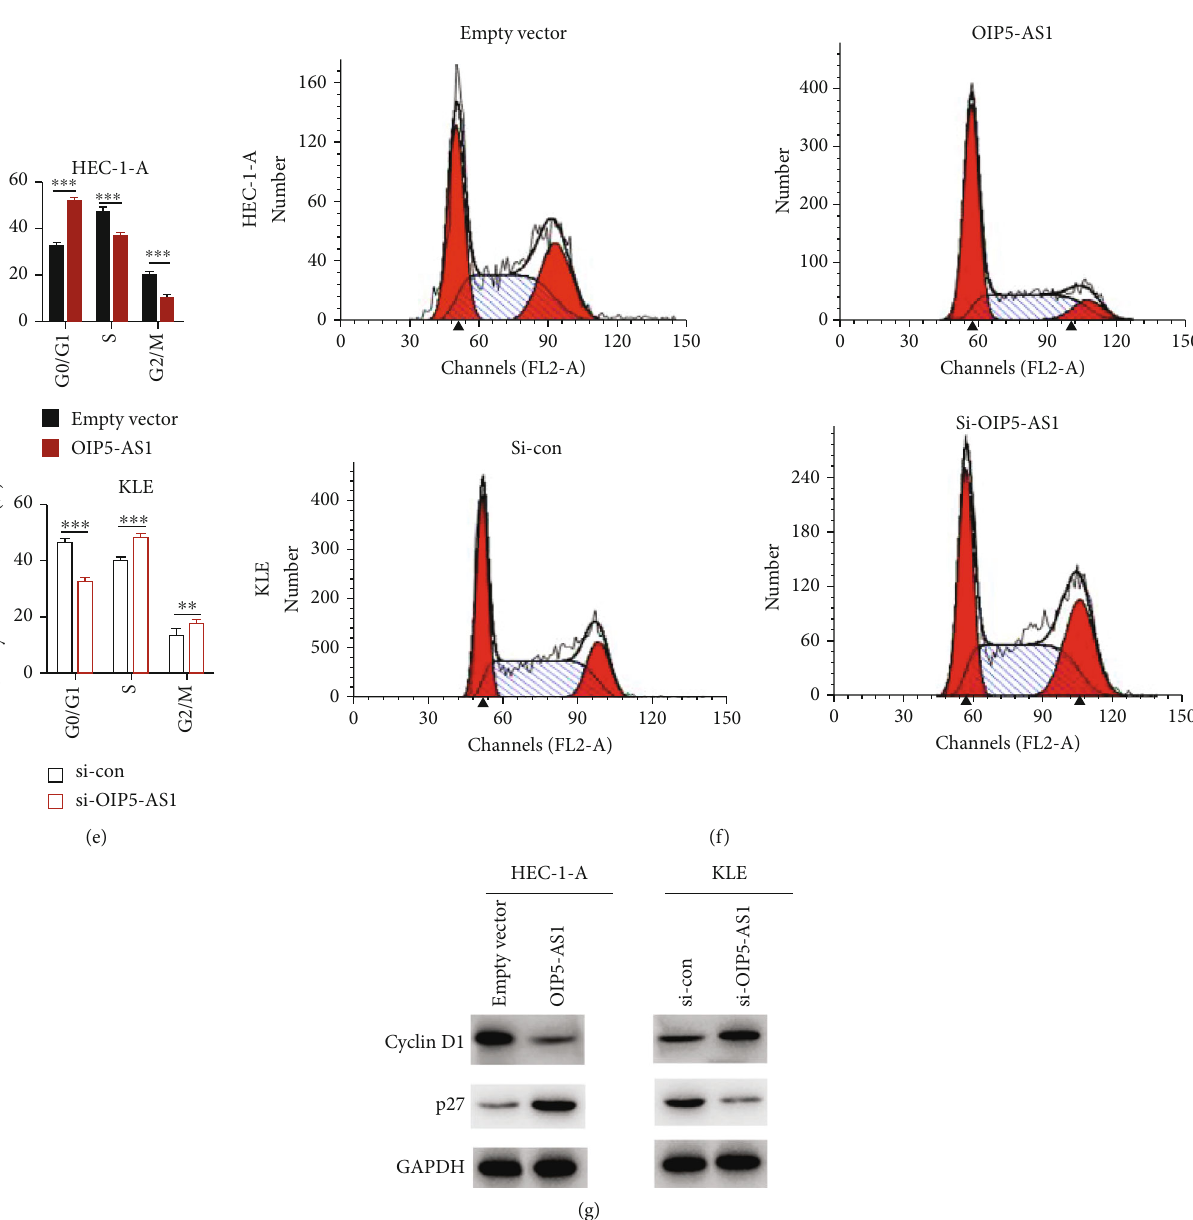
Figure 2: Upregulation of lncRNA OIP5-AS1 inhibited the proliferation of EC cell in vitro. (a) qRT-PCR was conducted to evaluate the expression of OIP5-AS1 in EC cell lines. After being transfected, OIP5-AS1 was signi fi cantly upregulated in the HEC-1A cell line compared with the empty vector group. Meanwhile, OIP5-AS1 was reduced in the KLE cell line by transfecting with the anti-OIP5-AS1 sequence. ∗∗∗ P < 0 : 001 . (b) CCK8 assay was used to measure cell vitality of HEC-1-A and KLE cells after transfection for 12, 24, 48, and 72 hours. (c) EDU staining was applied to label the DNA synthesis in HEC-1-A and KLE cells, which were transfected with OIP5-AS1 and its interfering RNA. Green represents EDU-positive cells; blue represents the cell nucleus. Scale bar 100 μ M. (d) Statistical result of EDU-positive cells. (e, f) Cell cycle was determined by fl ow cytometry. (g) Western blot analysis of cell cycle-related protein Cyclin D and p27 protein in the presence and absence of OIP5-AS1. Error bars represent the mean ± SEM of at least three independent experiments. ∗∗∗ P < 0 : 001 , ∗∗ P < 0 : 01 , and ∗ P < 0 : 05